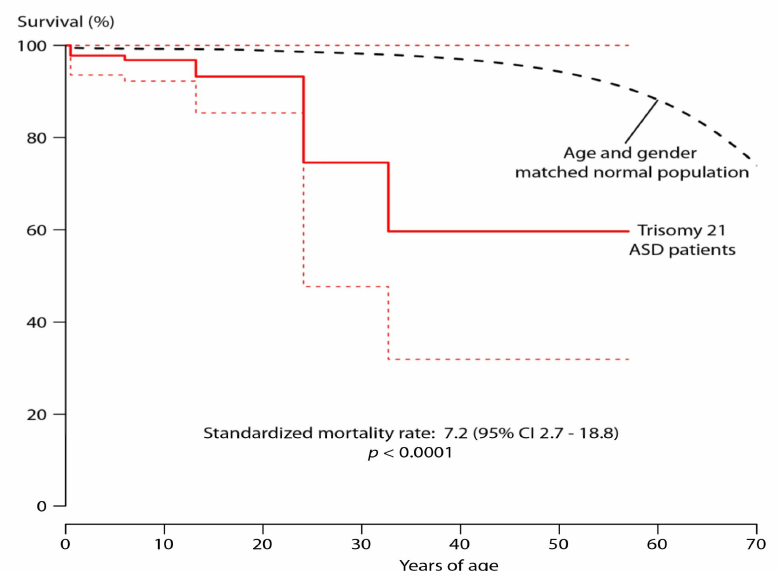
Figure 2. Survival of the overall Trisomy 21 ASD population (with 95% confidence intervals dotted line) compared to that of an age and gender matched sample of the general population. For details see Text. ASD refers specifically to ASD